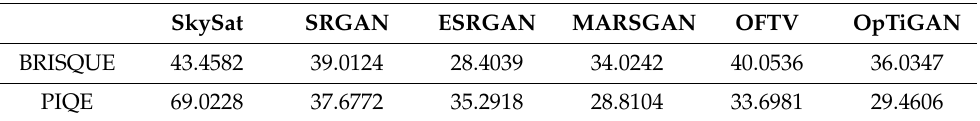
Table 8. BRISQUE and PIQE assessment of the SkySat video frame (reference frame) and its SRR results at Baotou Geocal